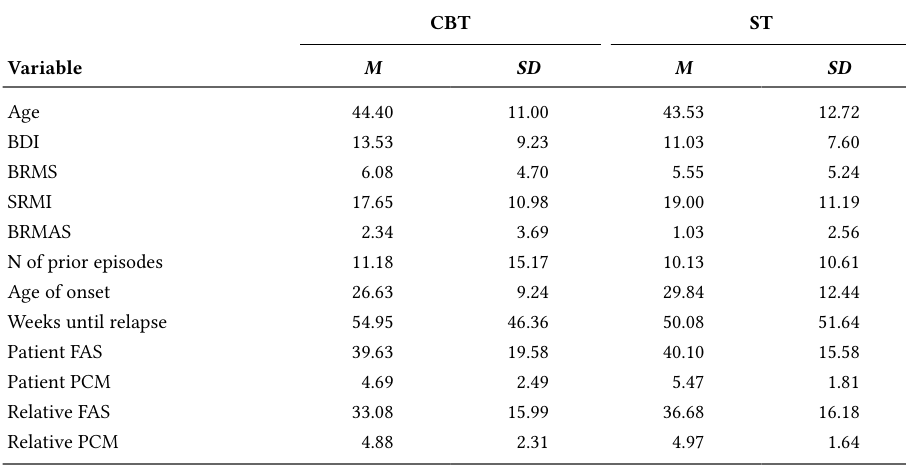
Means (M) and Standard Deviations (SD) of Patients With BD Who Received Either CBT or